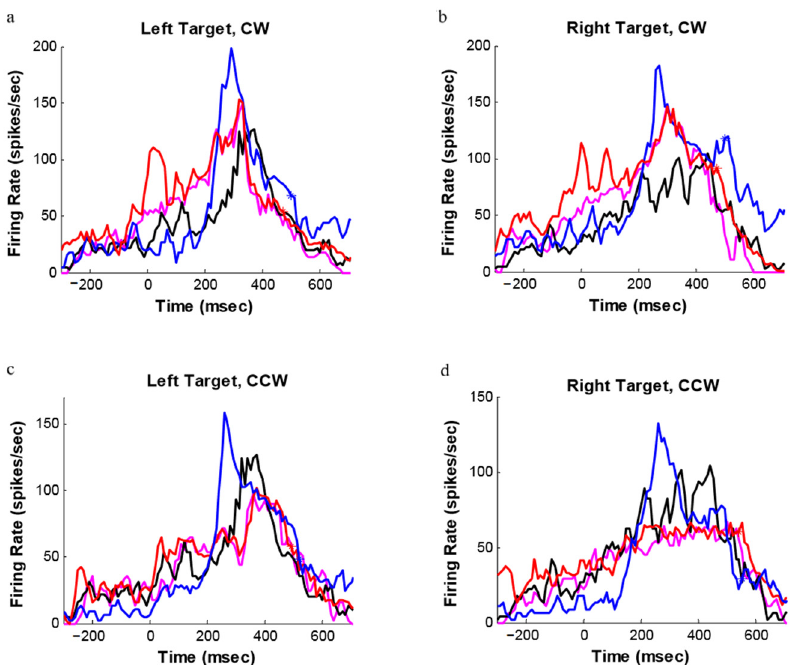
Figure 8. Histograms for one motor cortical neuron during movements ( a ) to left targets under CW perturbation with repeat perturbation (red), with random perturbation (blue), 90 ◦ unperturbed (black), and 135 ◦ unperturbed (magenta); ( b ) to right targets under CW perturbation with repeat perturbation (red), with random perturbation (blue), 90 ◦ unperturbed (black), and 135 ◦ unperturbed (magenta); ( c ) to left targets under CCW perturbation with repeat perturbation (red), with random perturbation (blue), 90 ◦ unperturbed (black), and 45 ◦ unperturbed (magenta); ( d ) to right targets under CCW perturbation with repeat perturbation (red), with random perturbation (blue), 90 ◦ unperturbed (black), and 45 ◦ unperturbed (magenta).